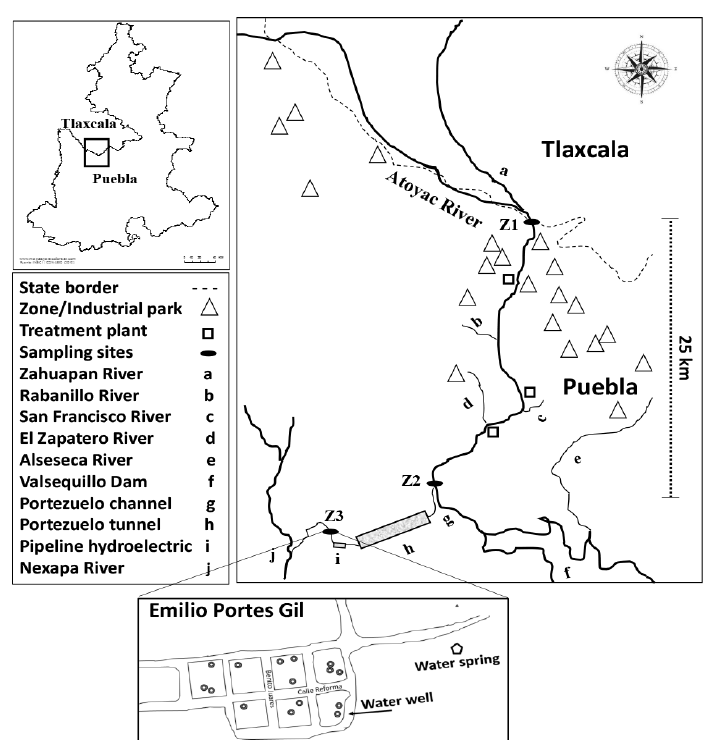
Figure 1. The study area map. Z1: Covadonga Dam, Z2: Echeverría Dam, and Z3: irrigation channel in EPG.